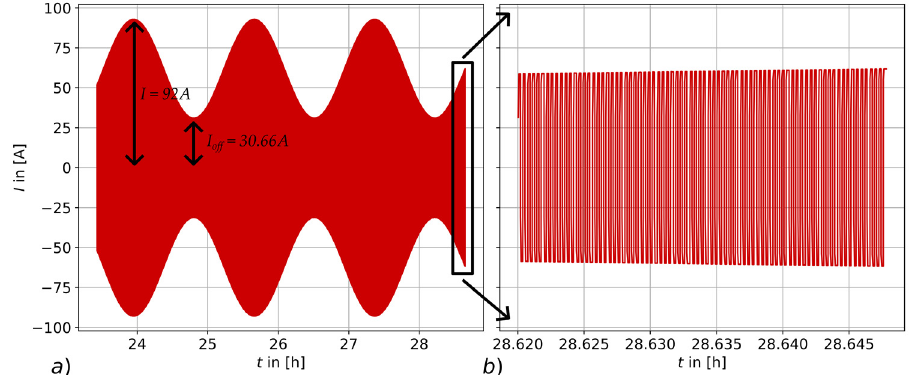
Figure 1. Section of modulated current signal for 160 μ Hz data point. ( a ) General behaviour, showing the amplitude and the offset; ( b ) zoomed data to show the 5 Hz carrier signal overlaid to the tested frequency.